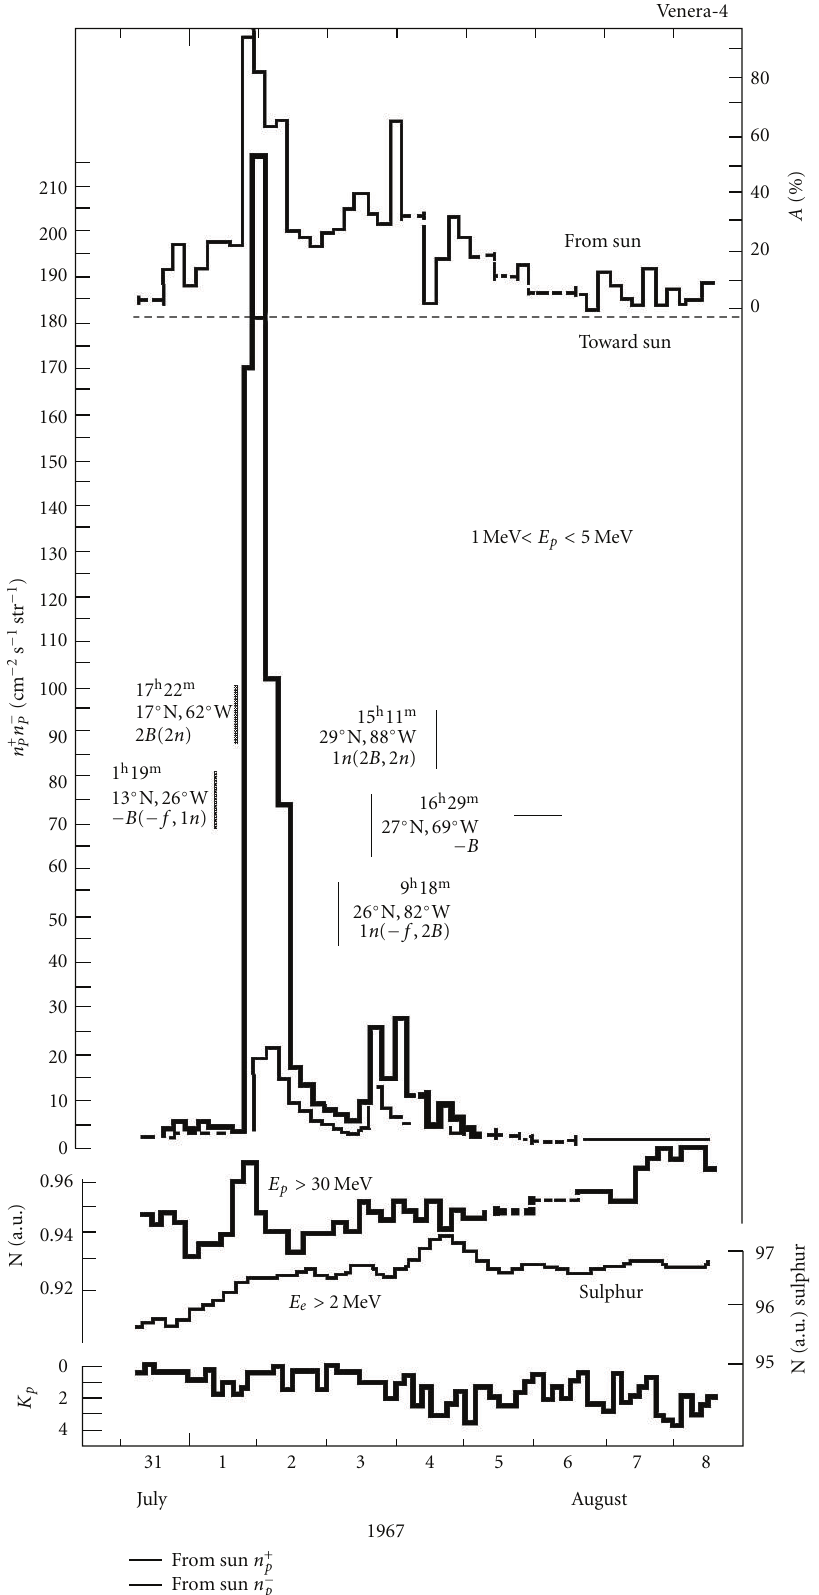
Figure 13: Fluxes of particles from a couple of solar flares during July-August 1967, according to the measurement of instrument AMS aboard Venera-4. Upper curves indicate the anisotropy of protons with Ep > 1MeV. The thick line represents the proton flux from the Sun; the thin one is toward the